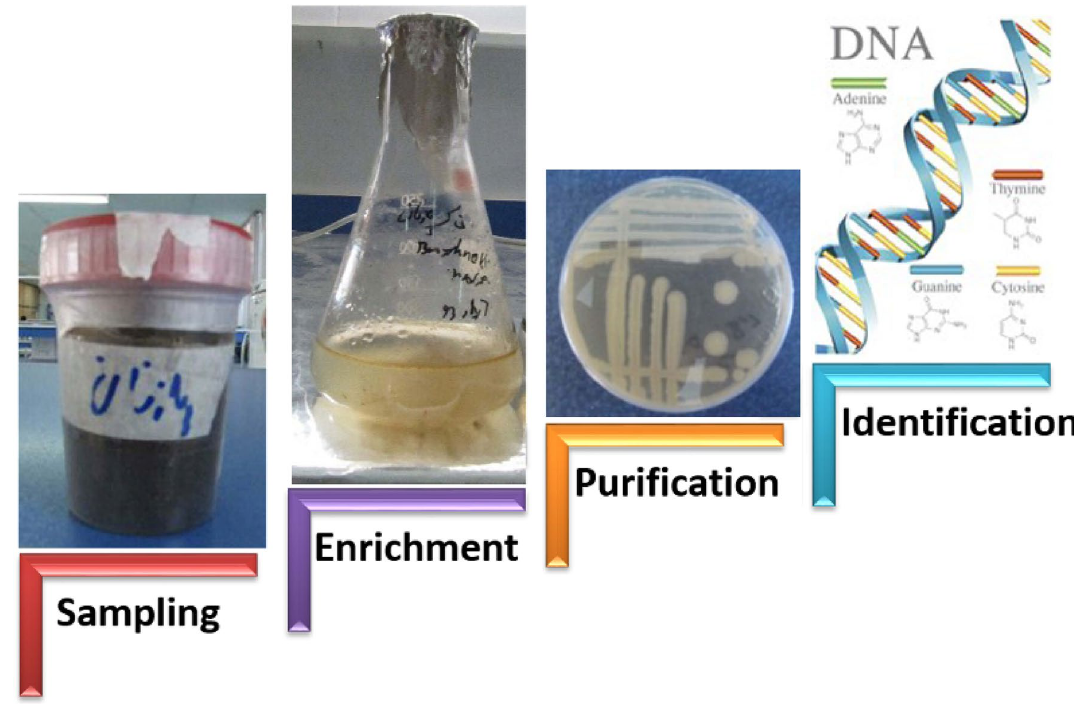
Fig. 1 Schematic representation of the isolation procedure of MJ01 and